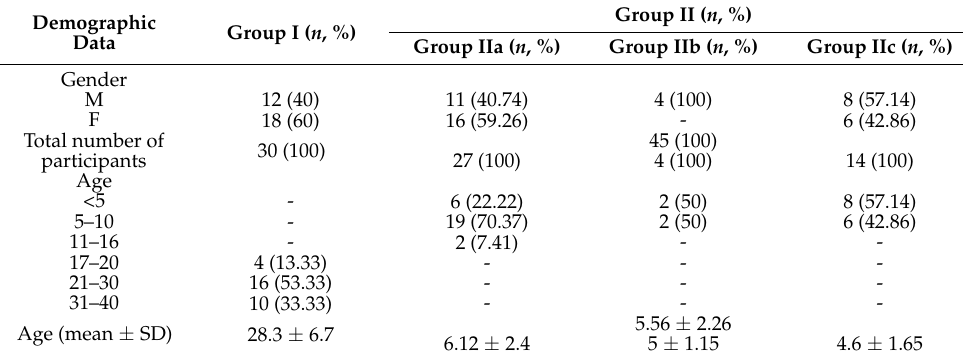
Table 1. Demographic data of 75 studied patients with chronic